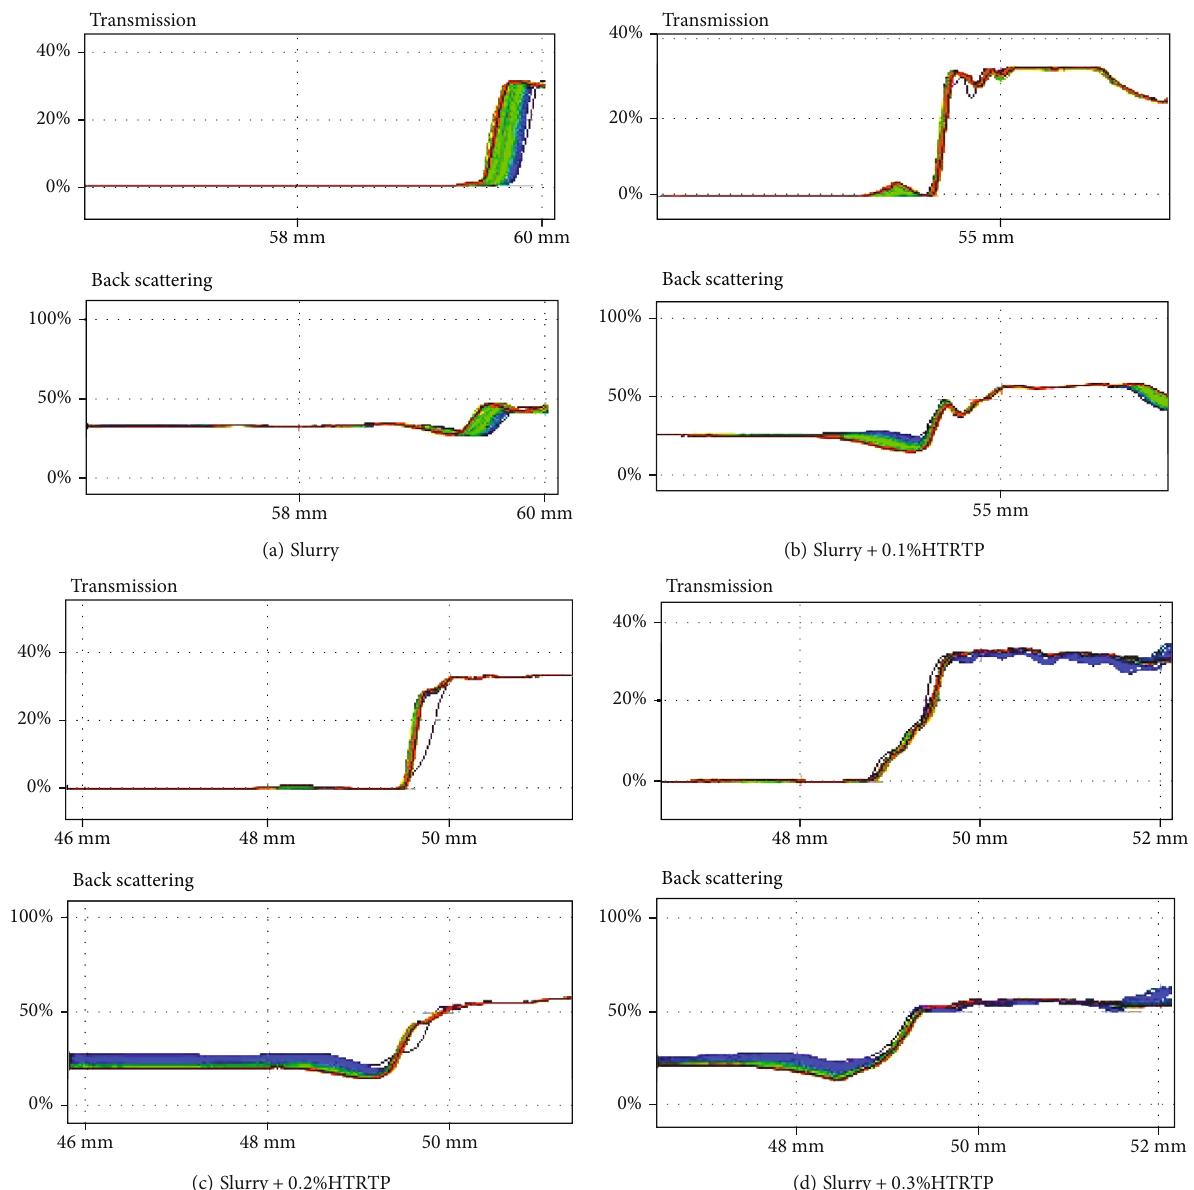
Figure 10: E ff ect of HTRTP on colloid stability of bentonite grouting (after